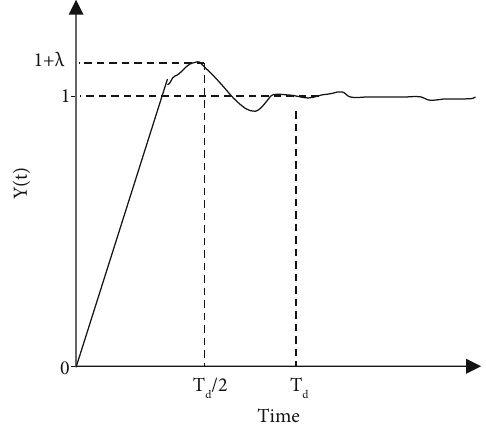
Figure 3: Result of a lightly damped FKYBC 55 with step